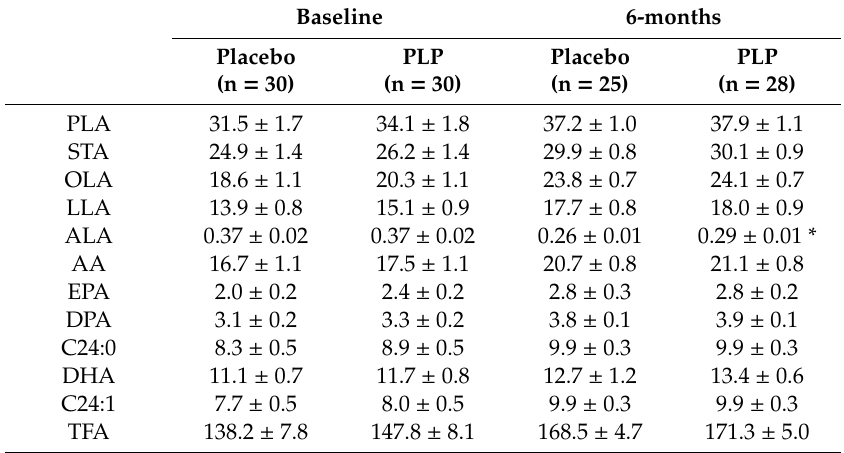
Table 4. Fatty acid profile ( µ g / mg protein) of the erythrocyte plasma membrane in the placebo and Perilla frutescens leaf powder-intake